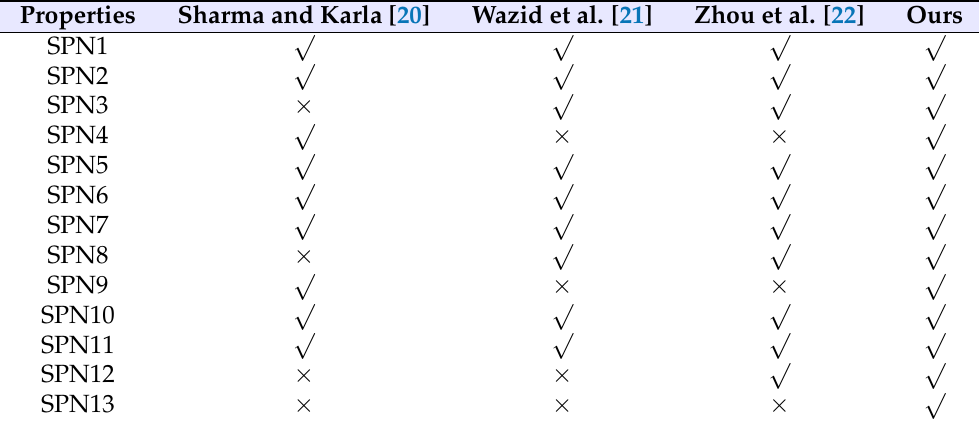
Table 8. A comparative summary: security